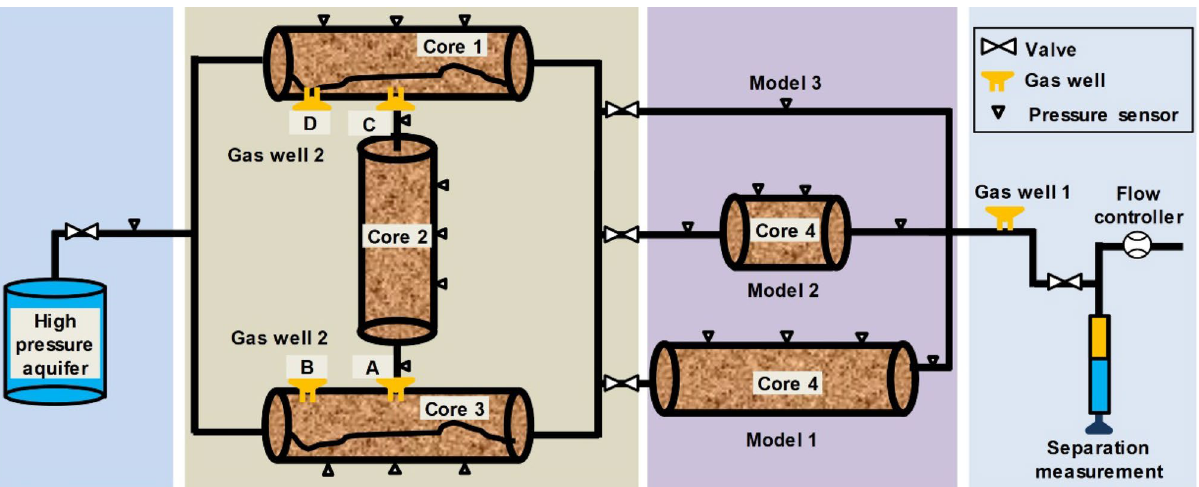
Figure 3. Schematic diagram of the joint water-control experiments (three geological models, Well 2 at points